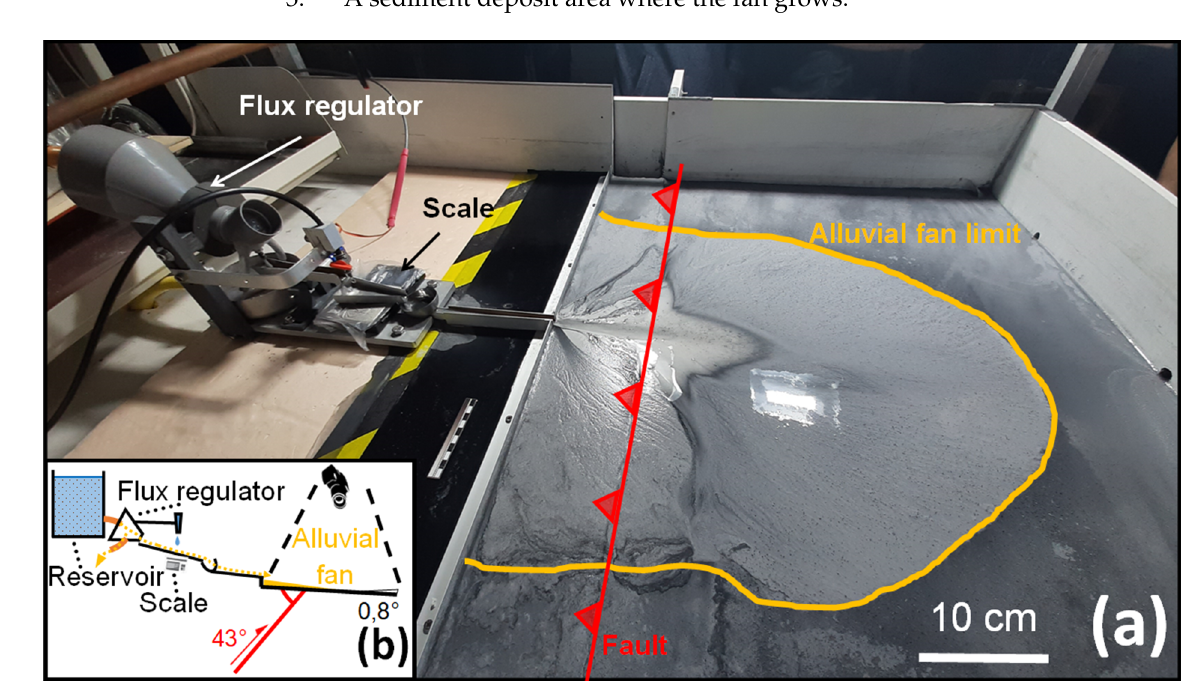
Figure 1. Experimental device used to perform the analog models. ( a ) General picture of the setup. On the left, the sediments go through a regulator flux then are weighed on the scale. On the right, the alluvial fan is deposed on an area of 60 × 60 cm. The alluvial fan boundary is outlined by an orange line, and the fault by a red line. ( b ) Schematic diagram of the experimental setup showing the circulation of sedimentary flux. The depositional area has a small slope of 0.8 ◦ and a reverse fault with a dip of 43°.